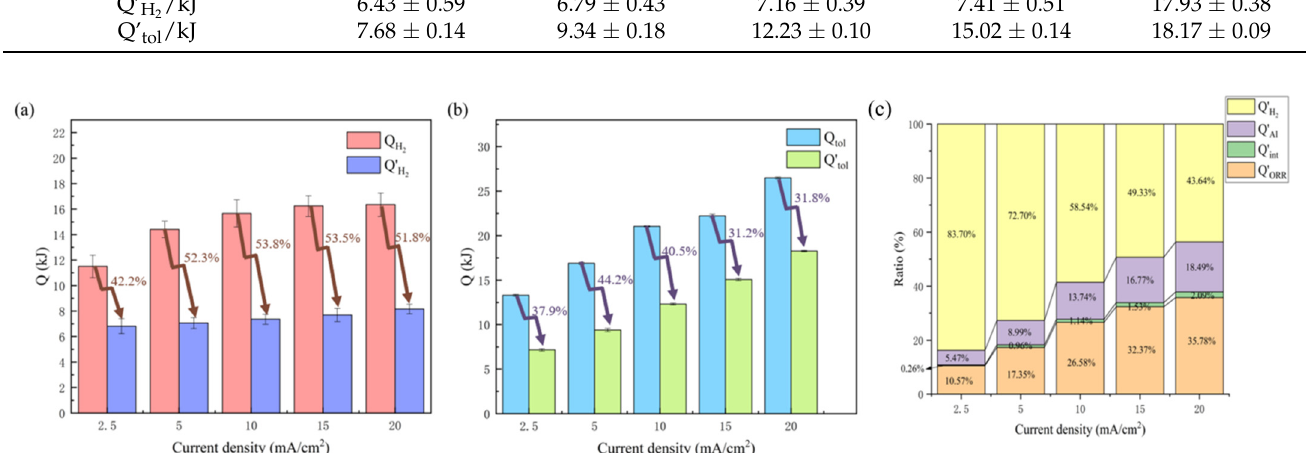
Figure 10. Comparison of ( a ) heat generated by hydrogen-evolution reaction, ( b ) total heat, and ( c ) the proportion of each part with modification by electrolyte additives. Table 4. The hydrogen-evolution reaction, the heat generated by the hydrogen-evolution reaction and total heat after regulating the hydrogen-evolution